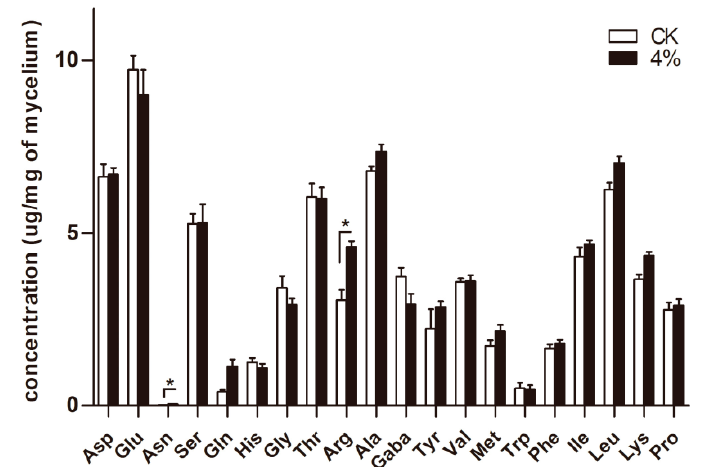
Figure 7. Alterations in the intracellular amino acid content under the condition of 4% ethanol at 36 h post-treatment. The bars represent the average ( ± SE) of biological repeats. Asterisks indicate statistically significant differences between groups ( t -test): * denotes P < 0.05.